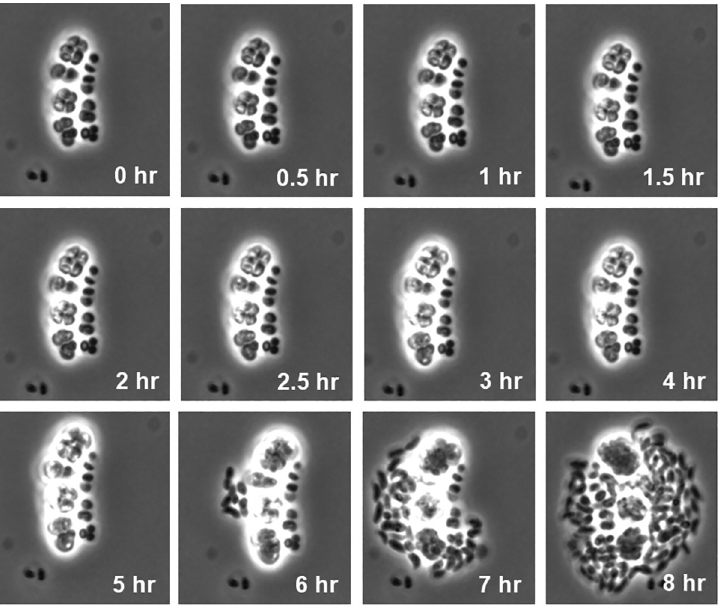
Fig 2. Oil immersion microscopic analysis of refractile cyst cells undergoing germination over an 8-hour period.